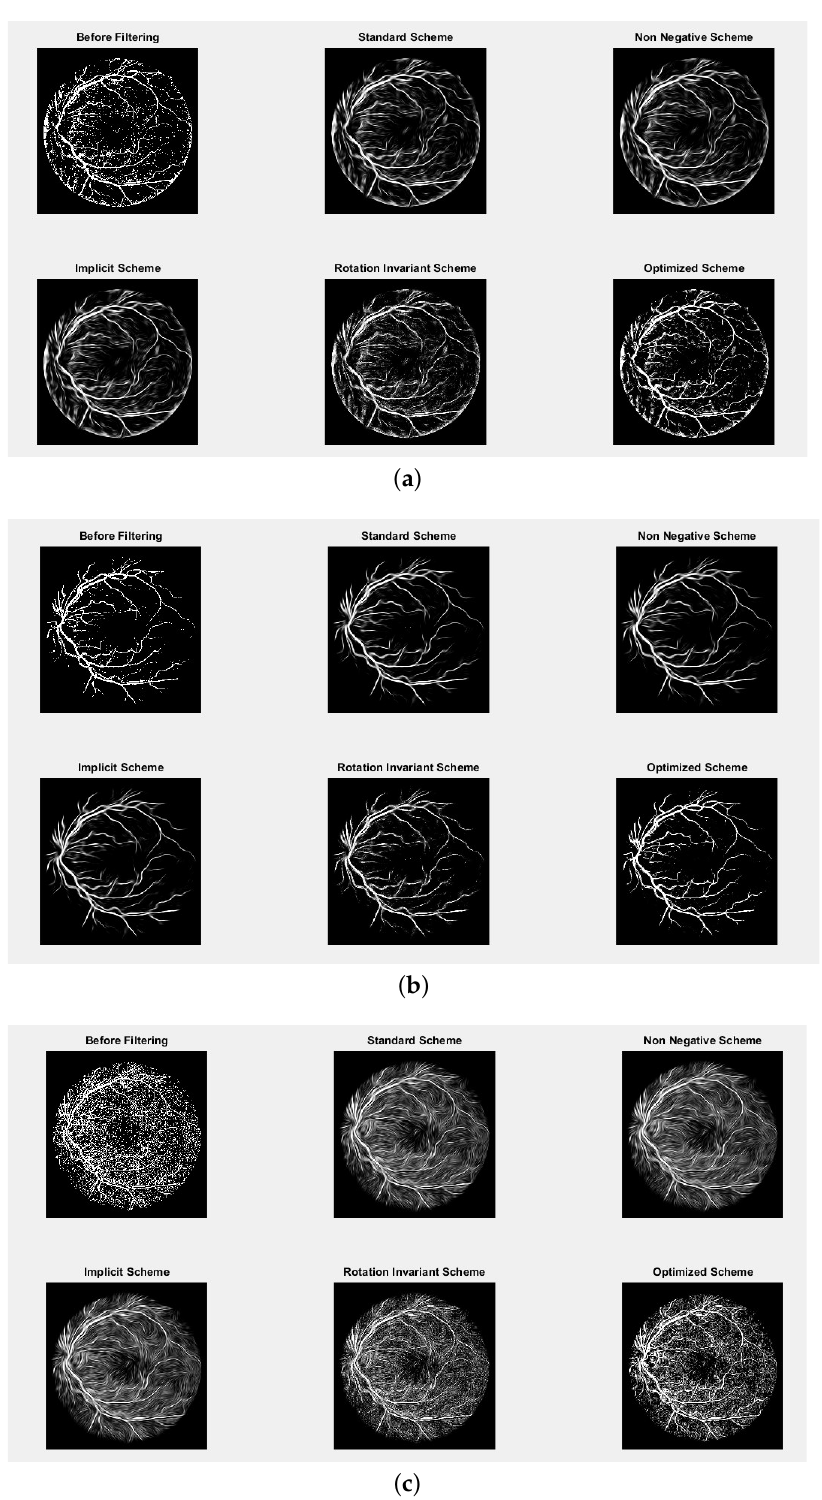
Figure 7. Oriented Diffusion Output. ( a ) Comparison of Oriented Diffusion Red Channel output on other Oriented Diffusion filtering Schemes ( b ) Comparison of Oriented Diffusion Green Channel output on other Oriented Diffusion filtering Schemes ( c ) Comparison of Oriented Diffusion Blue Channel output on other Oriented Diffusion filtering